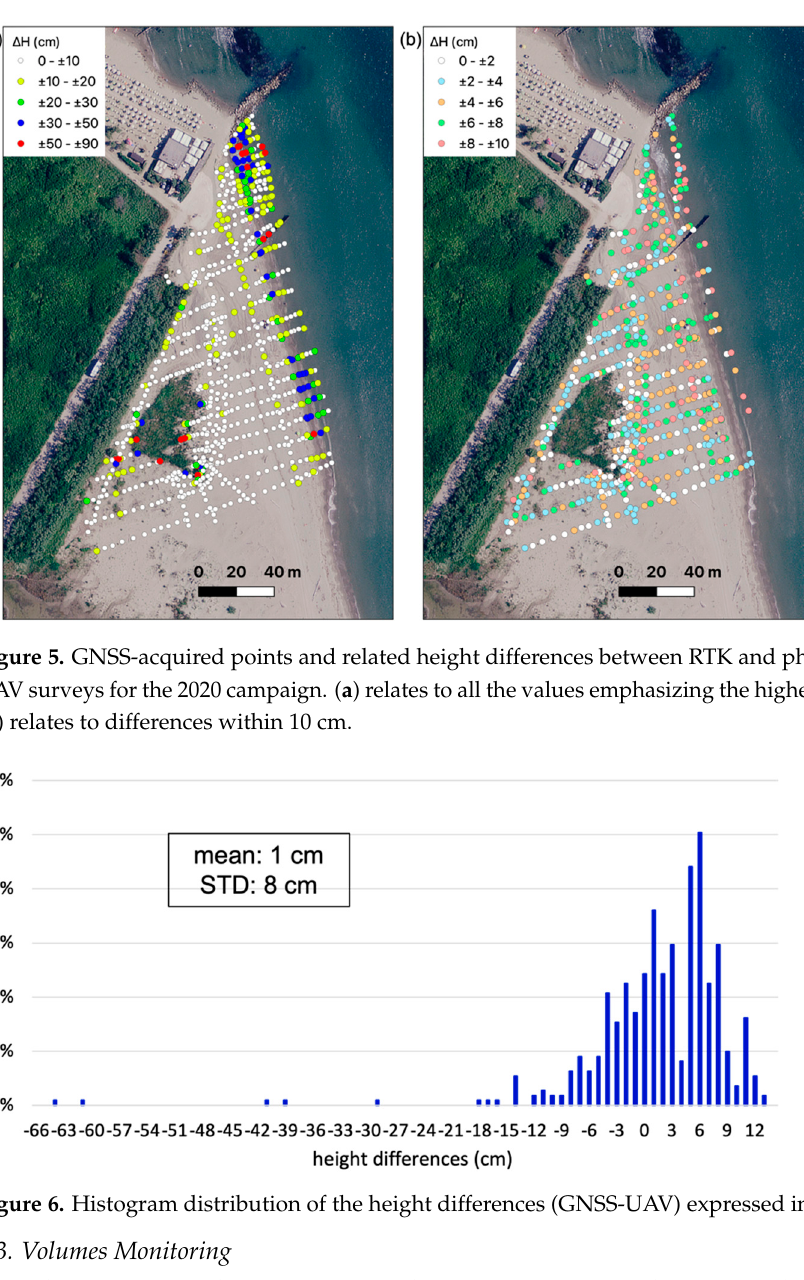
Figure 6. Histogram distribution of the height differences (GNSS-UAV) expressed in cm.